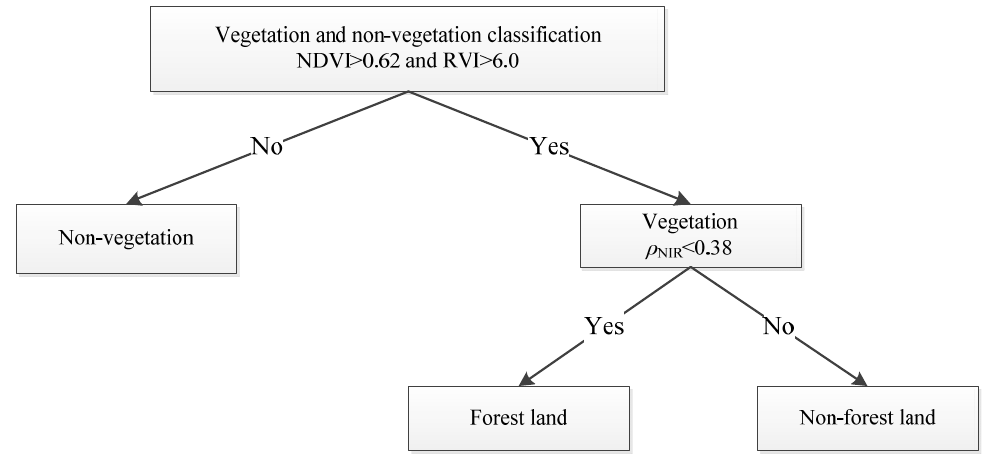
Figure 3. TM/OLI scene classification based on the decision tree classification model. Figure 3. TM / OLI scene classification based on the decision tree classification